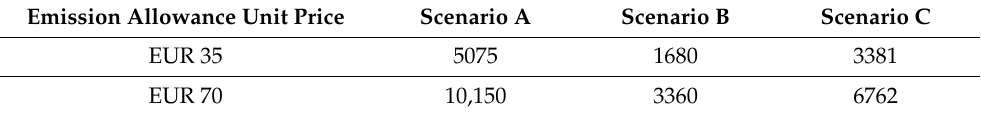
Table 1. Cost increase for maritime sector assuming 100% auctioning, expressed in MEUR.